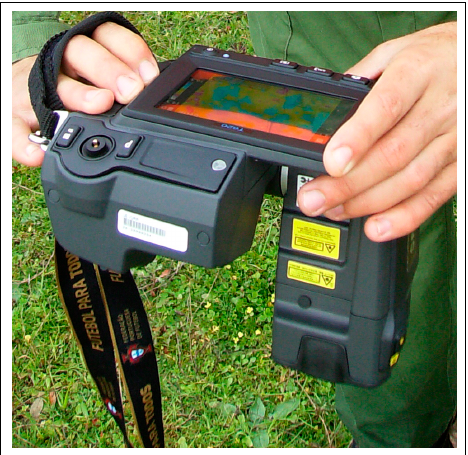
Figure 7. ThermaCAM TM infrared camera used to measure the temperature at the pasture surface.